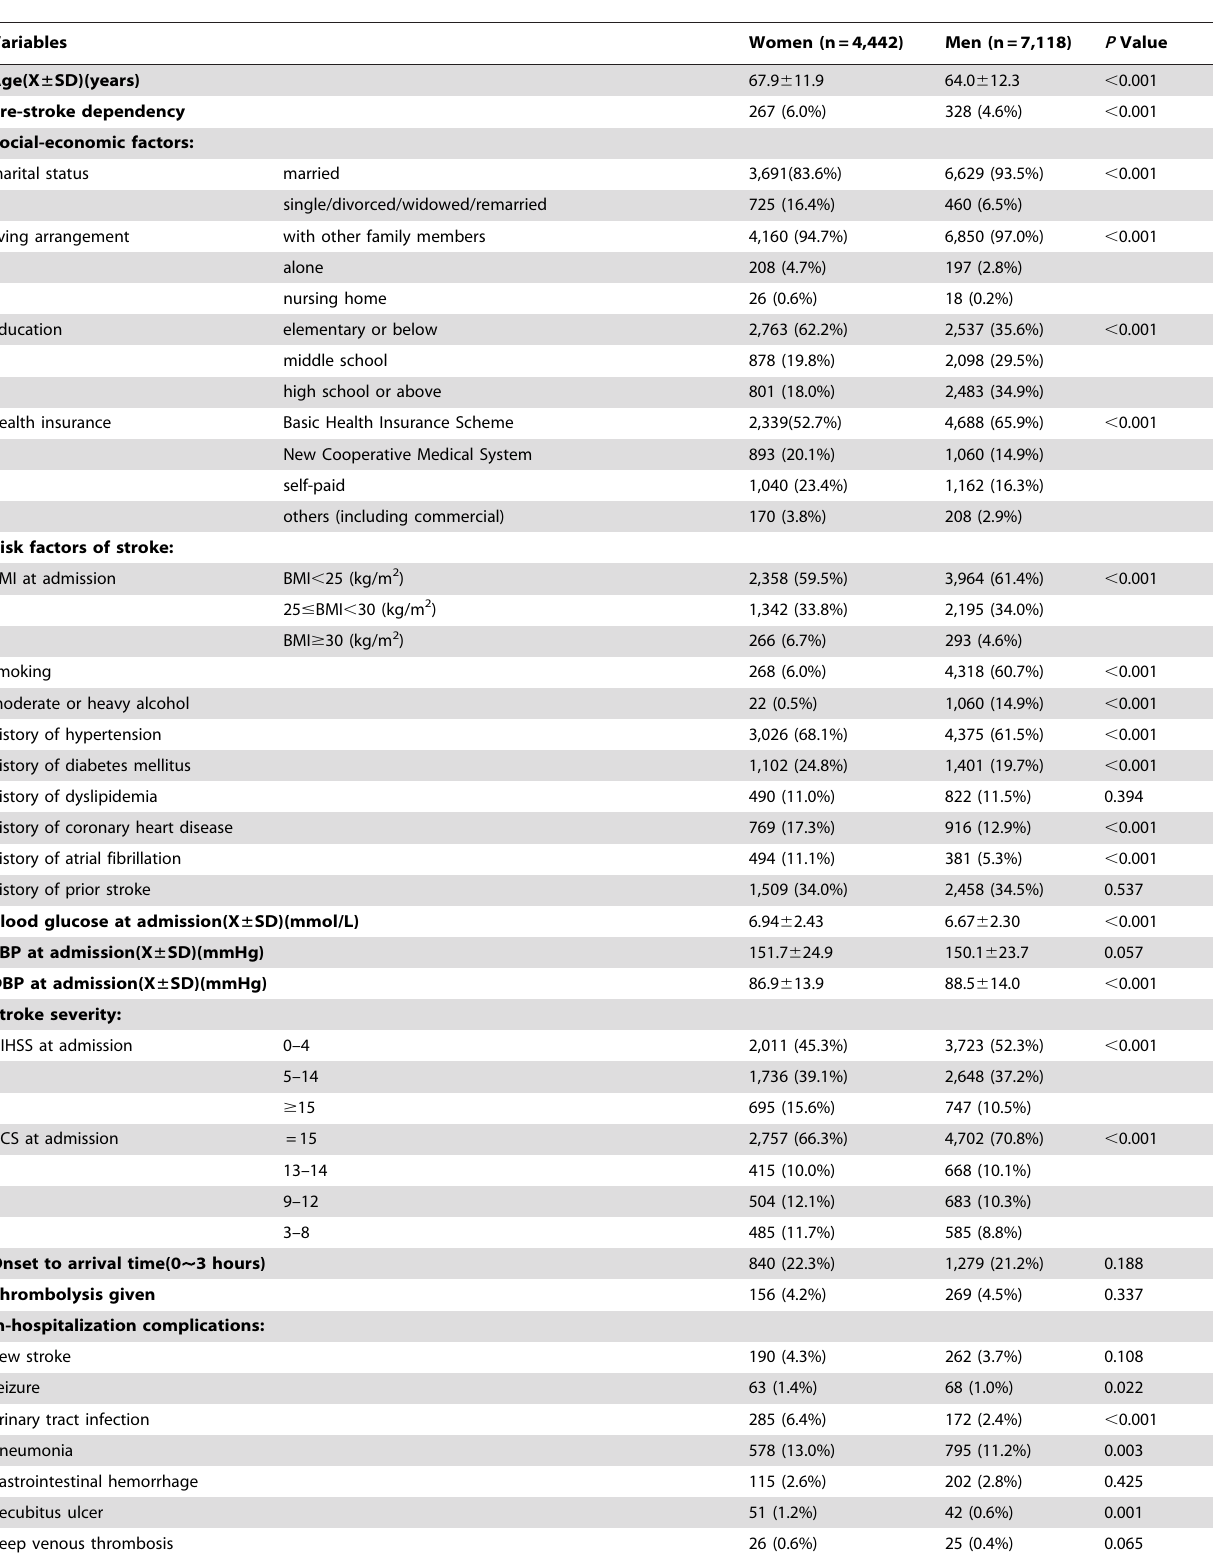
Table 2. Baseline characteristics of different gender patients with ischemic